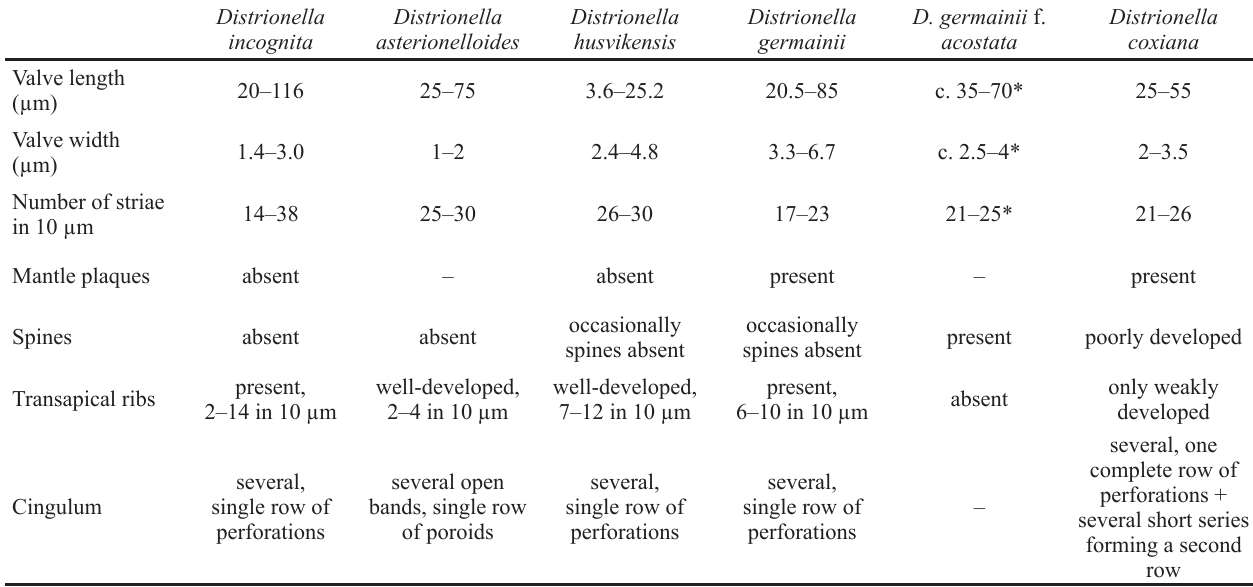
Table 1 – Table of comparison of all Distrionella taxa described worldwide. * measured based on illustrated valves in Rumrich et al.